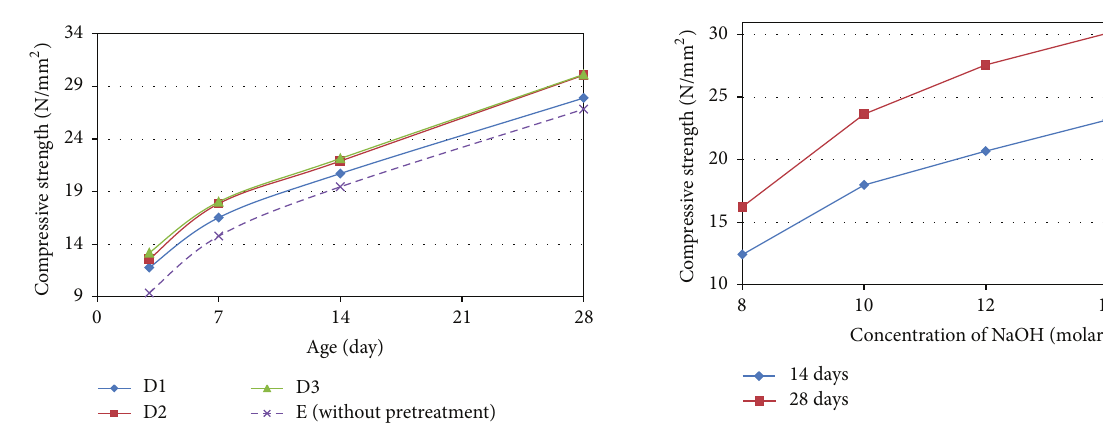
Figure 11: Compressive strength distribution for the OPSGPC with PVA solution treated OPS in ambient-cured condition.